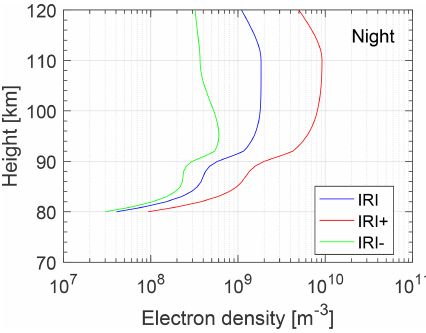
Figure 8. The electron density profiles during nighttime. IRI repre- sents the original electron density predicted by the IRI model; IRI+ represents the electron-density-added Gaussian shape perturbation; IRI- represents the electron-density-subtracted Gaussian shape per-